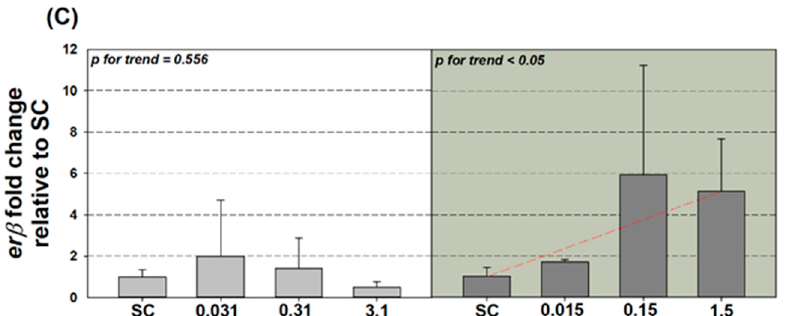
Figure 2. Transcriptional changes of ( A ) vtg , ( B ) er α , and ( C ) er β genes in male zebrafish liver exposed to DBDPE and BTBPE. The results are shown as mean ± SD of quadruplicates ( n = 4). Asterisk indicates a significant difference in treatment groups relative to the solvent control (0.1% DMSO, p < 0.05). The value of p for trend was determined based on the linear regression analysis. If p for trend was <0.05, a linear trend is indicated with a red dotted line.